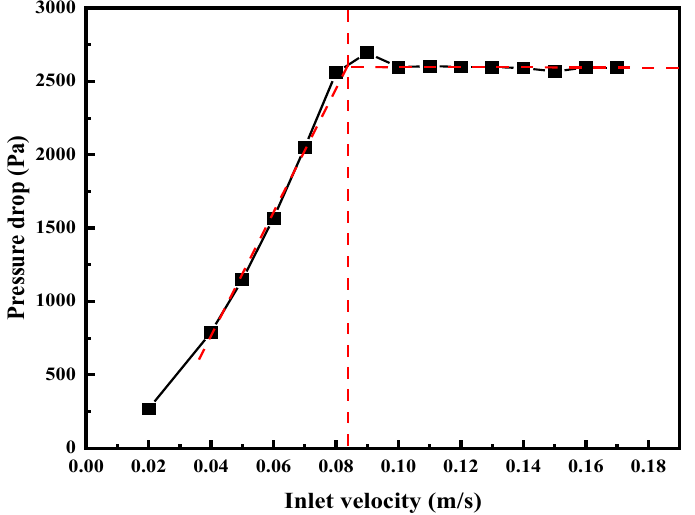
Figure 2. Relationship between pressure drop and superficial velocities in fluidized bed (25 MPa 699 K).